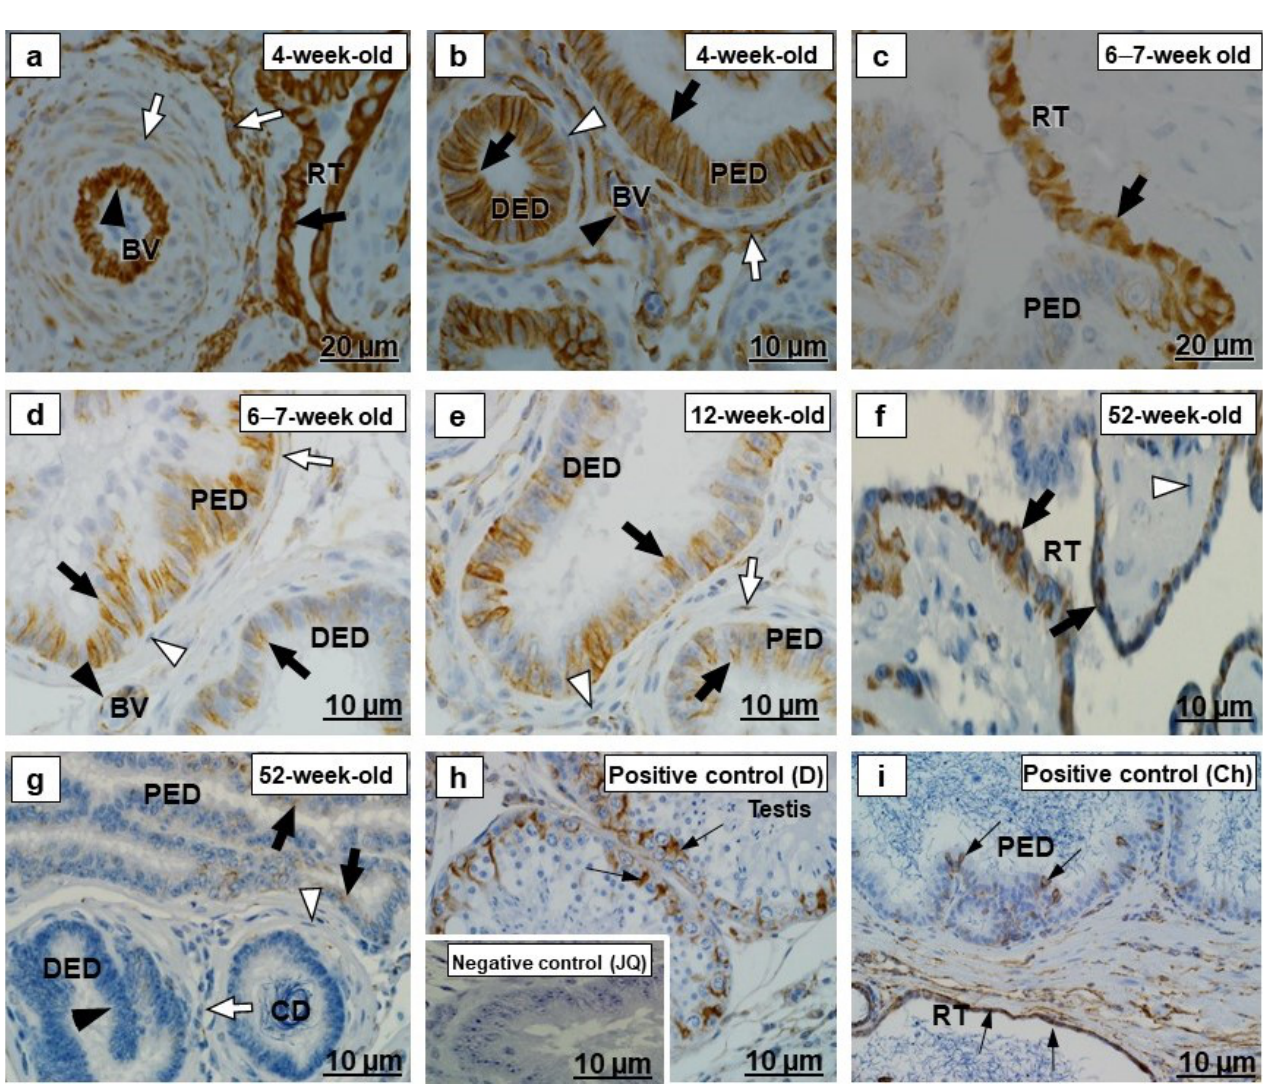
Figure 9. Immunolocalization of vimentin in the (RT) rete testis, (PED) proximal efferent duct and (DED) distal efferent duct of the testicular excurrent duct system of Japanese quails ( n = 7 per age group). ( a , b ) Strong immunostaining in the epithelial (black arrows), and vascular endothelial cells (black arrowheads), as well as fibroblasts (white arrows) of the RT, PED, and DED. ( c ) Black arrow in- dicates moderate to strong immunostaining in the RT epithelium. ( d , e ) Moderate immunostaining in the ciliated cells (black arrows) of the PED and DED. White arrows depict moderate to weak immunos- taining in the fibroblasts. ( f ) Weak to moderate immunostaining in the epithelium (black arrows) of the RT. ( g ) Black arrows show weak immunostaining in a few cells of the PED, immunonegative DED epithelium (black arrowhead) and fibroblast (white arrow). ( b , d – g ) Immunonegative smooth muscle cells (white arrowheads). Inset ( b ) Negative control: Efferent ducts of an adult Japanese quail. ( h , i ) Positive controls: Thin black arrows indicate immunopositive labeling in the Sertoli cells of the dog testis ( h ) and epithelial cells of the RT and PED of the chicken ( i ). CD, Connecting duct. BV, Blood vessel. Ch, Chicken. D, Dog. JQ, Japanese